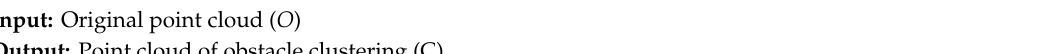
Algorithm 2 Obstacle point cloud